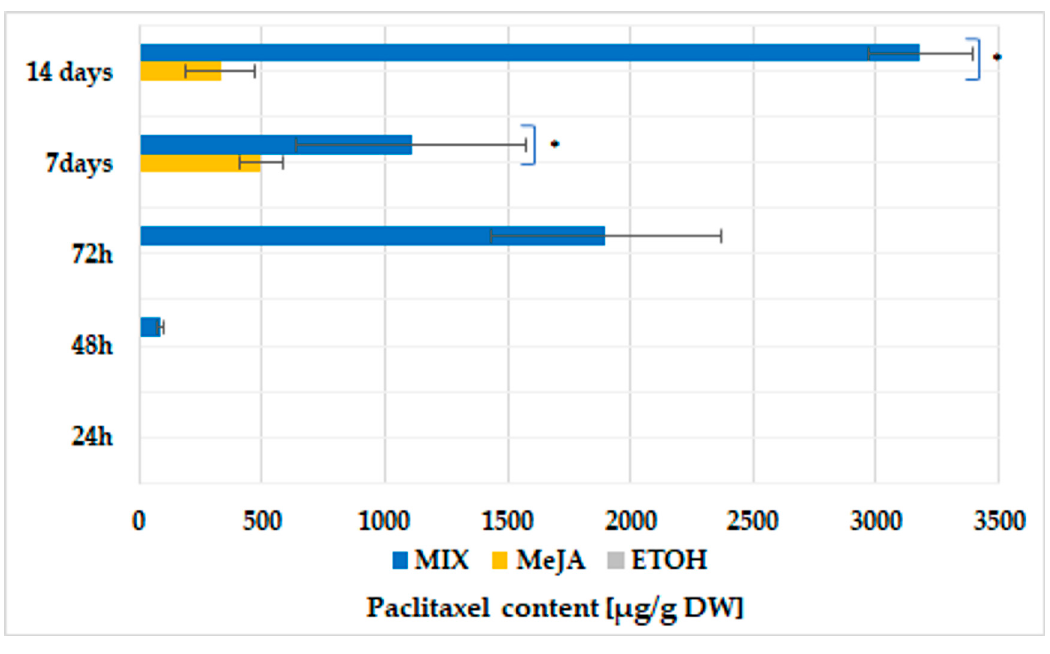
Figure 2. Paclitaxel content [µg/g DW] determined in hairy roots cultivated in various culture conditions: ( a ) without BABA supplementation; ( b ) elicited after treatment with BABA for 24 h; ( c ) elicited after treatment with BABA for 1 week. Data represent mean values ± SD from three independent experiments. Data denoted with asterisks (*) are statistically significant ( p ˂ 0.05).